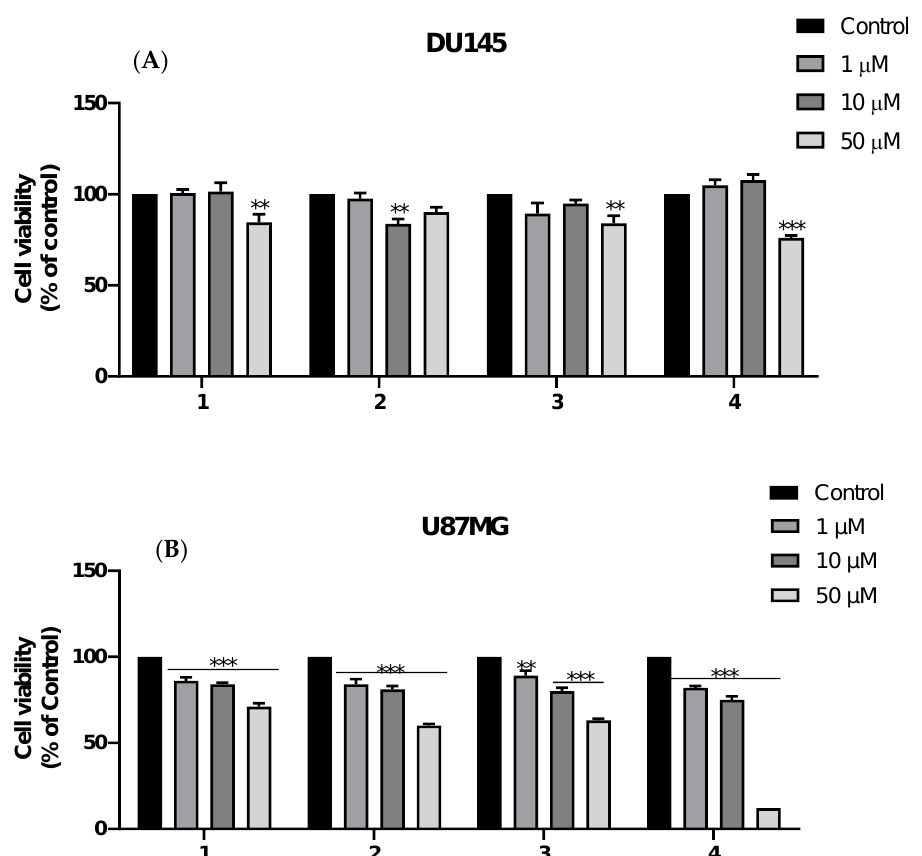
Figure 5. Effect of HO-1/ σ R hybrids 1 – 4 treatments on cell viability of DU145 (panel A ) and U87MG (panel B ) cell lines, assessed by MTT assay at the doses of 1, 10 and 50 µ M. Results are representative of at least three independent experiments and values are expressed as percentage of control (% of control). Data represent means ± SEM. ** p < 0.01, *** p < 0.001 vs. control as determined by one-way ANOVA followed by Tukey’s multiple comparison test.